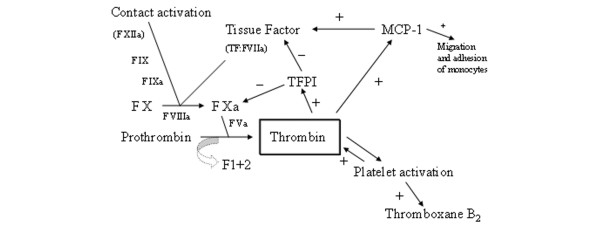
Role of thrombin in the coagulation system. Thrombin has a central role in different interactions of the coagulation system as shown. Cleavage of prothrombin fragment 1+2 (F1+2) from prothrombin results in thrombin formation. Thrombin production leads to tissue factor pathway inhibitor (TFPI) upregulation, which inhibits tissue factor (TF) activity. Monocyte chemoattractant protein-1 (MCP-1) production is also increased via thrombin interaction.